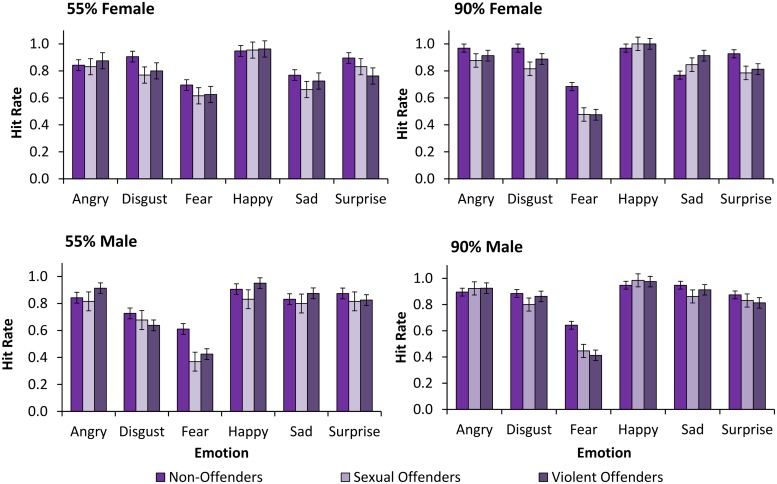
Hit rates (HR). HR are shown by emotion expressed for female faces at moderate intensity, female faces at high intensity, male faces at moderate intensity, and male faces at high intensity, for non-offenders, sexual offenders, and violent offenders. Error bars = SE mean.